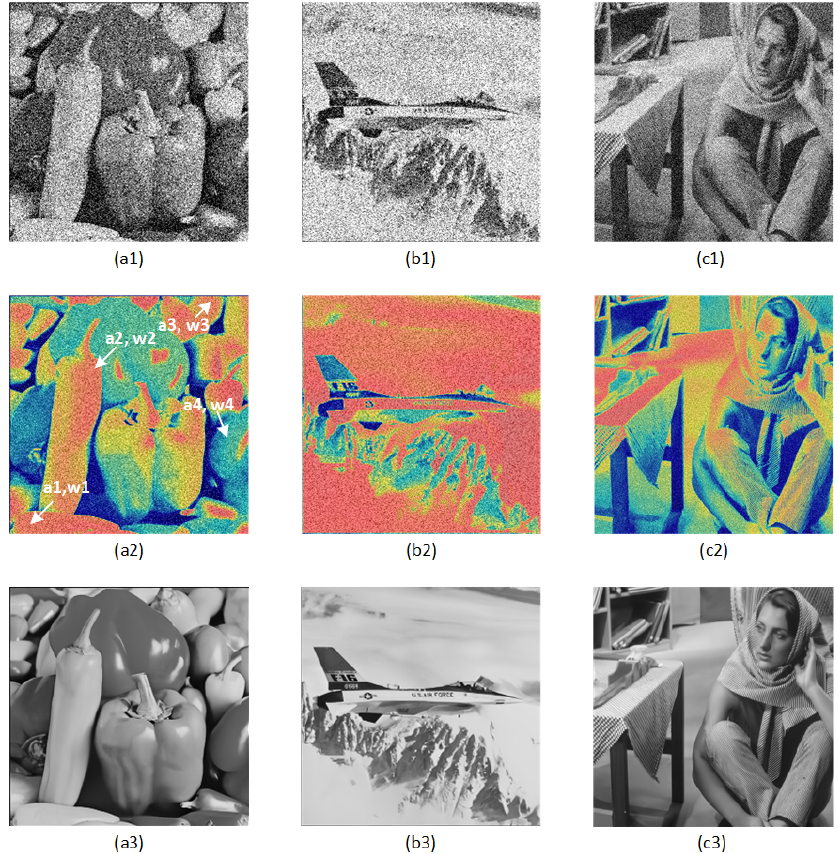
Figure 9. The thermodynamic image of RDASM is proposed. ( a1 – a3 ) are the noise images, ( b1 – b3 ) are the corresponding heatmaps, ( c1 – c3 ) are the corresponding denoising images. In ( a2 ) figure, the details of ( a1 – a3 ) are similar, and the weights w1, w2, and w3 are similar. Red indicates high weight, and attention gives more weight to key